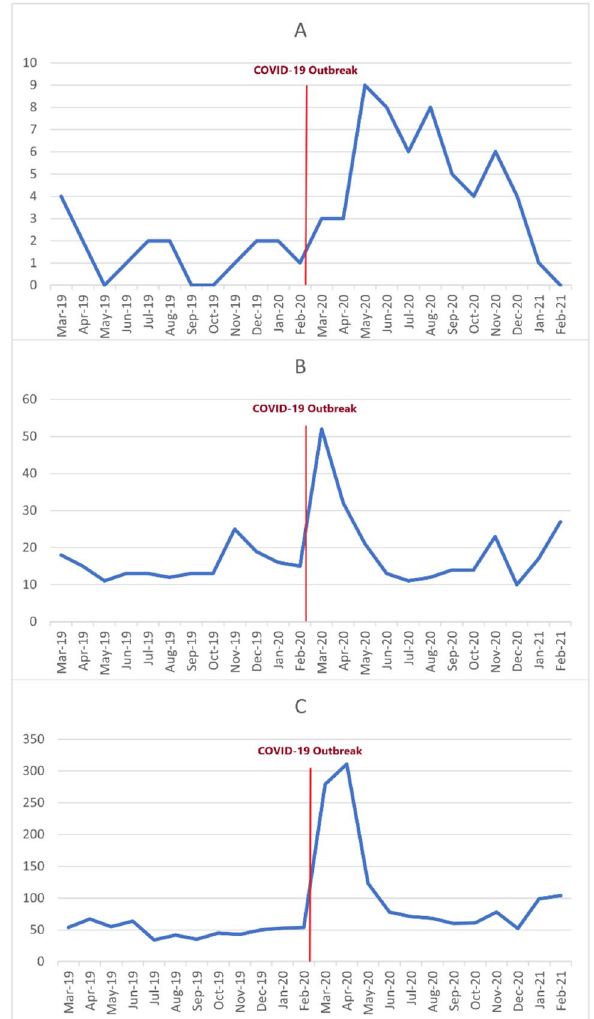
Figure 2. Trend of alcohol intoxication among children ( A ), adolescents ( B ), and Adults ( C ) Pre-COVID 19 and during